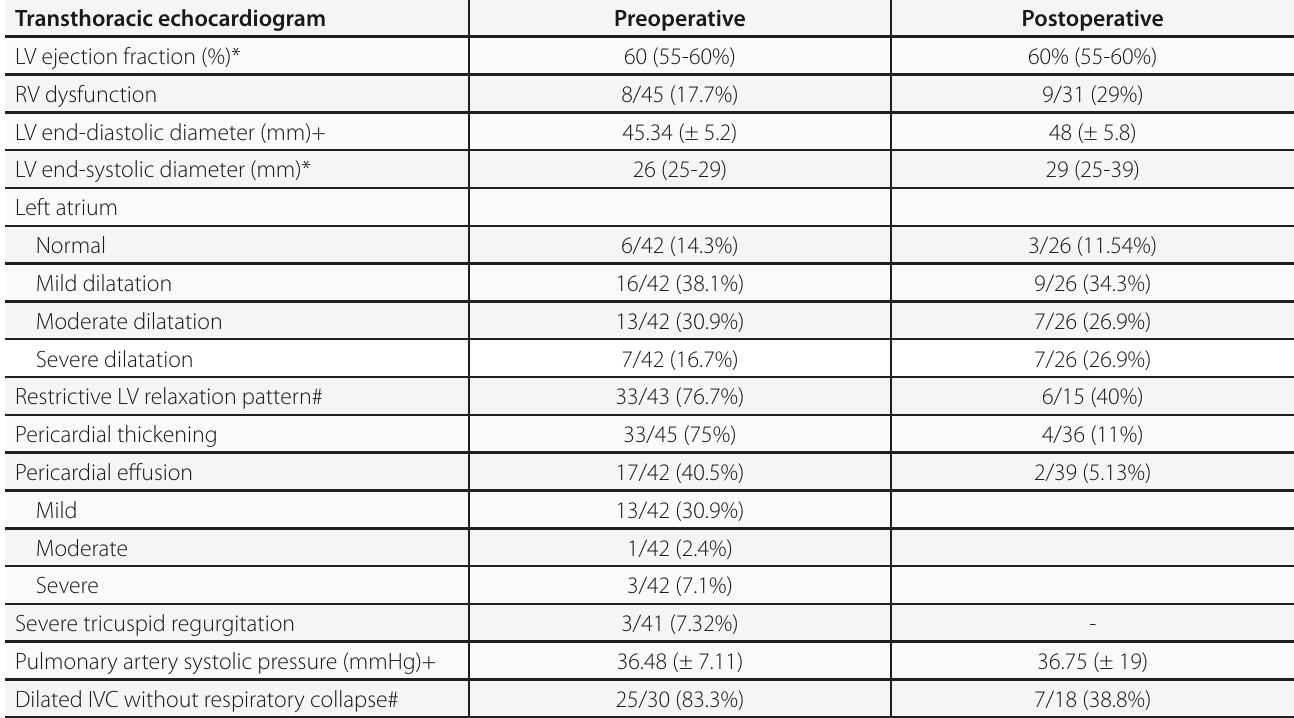
Table 2. Comparison of preoperative and postoperative